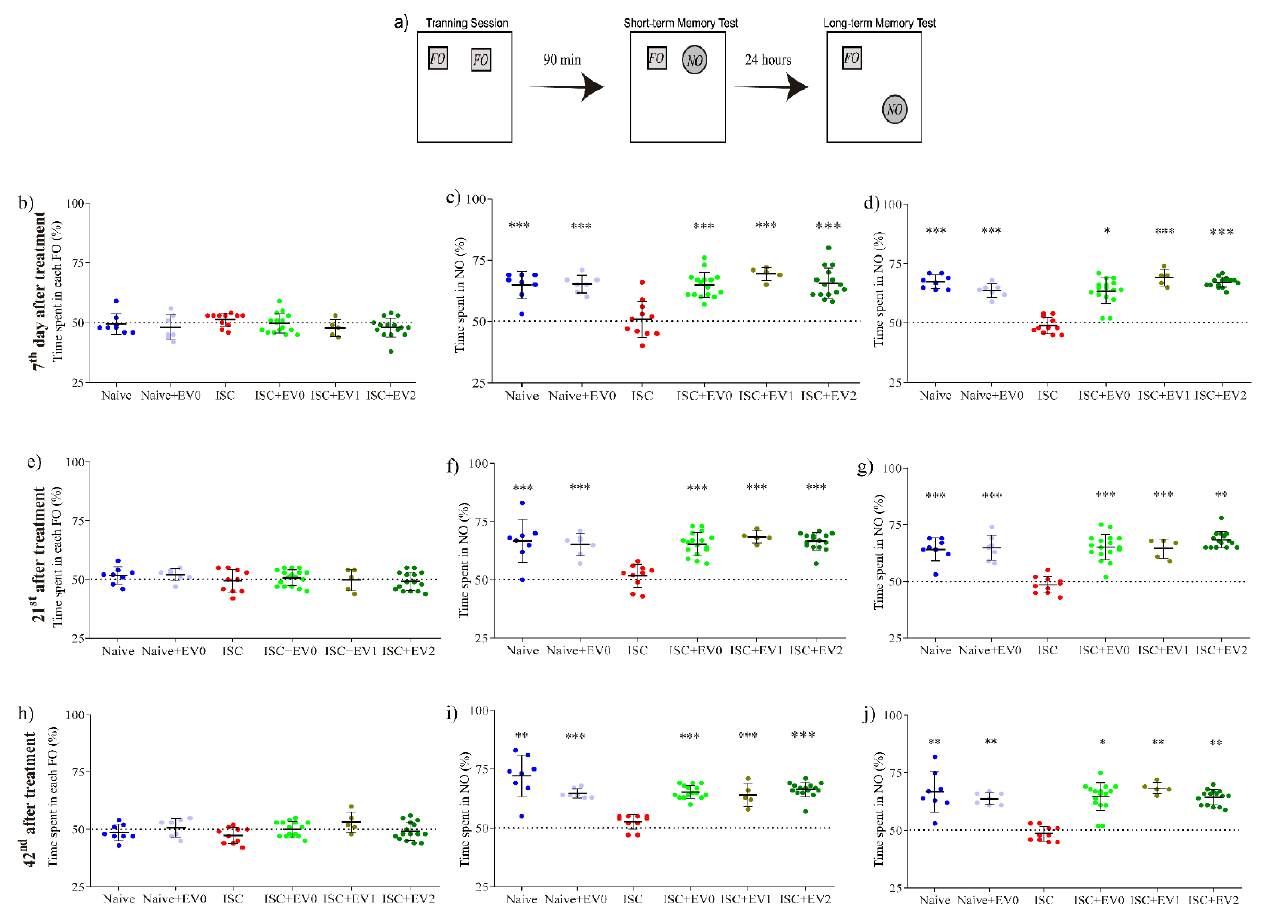
Figure 7. Novel object recognition task. Sessions were performed on days 7, 21, and 42 after treatment. ( a ) Scheme of the protocol using familiar object (FO) and novel object (NO). Groups: naive (n = 8), naive + EV0 (n = 7), ISC (n = 16), ISC + EV0 (n = 16), ISC+EV1 (n = 5), and ISC+EV2 (n = 16). ( b , e , h ) 3 successive training sessions; ( c , f , i ) 3 successive short-term memory test sessions; ( d , g , j ) 3 successive long-term memory test sessions. Unpaired t test with a theoretical average of 50%. Data reported as mean ± SD; * p < 0.05, ** p < 0.01, and *** p < 0.001, compared with the theoretical average of 50%.